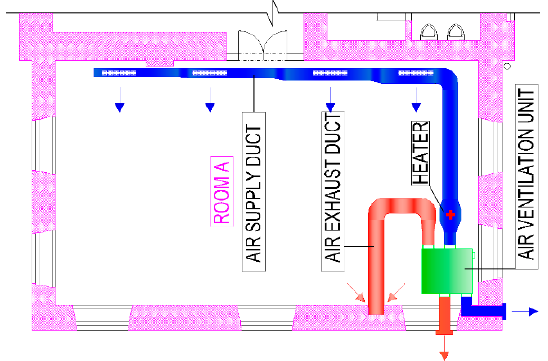
Figure 2. Floor plan of the investigated classroom with the designed heating, ventilation, and air conditioning (HVAC) system marked.